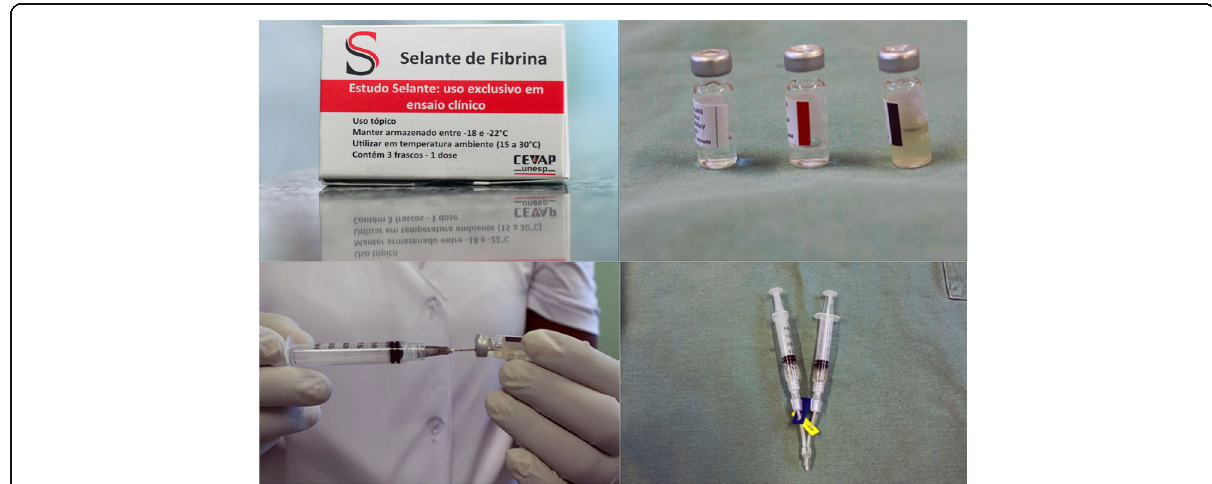
Fig. 11 Packaging and vials approved only for clinical research